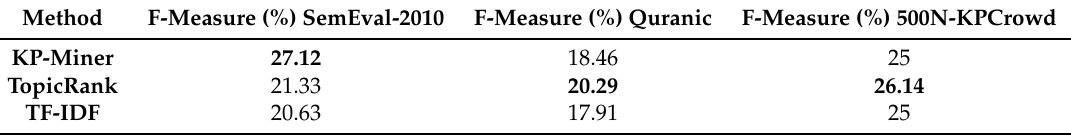
Table 6. Comparison in terms of